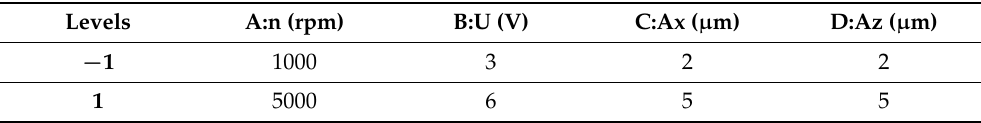
Table 4. Level of factors for